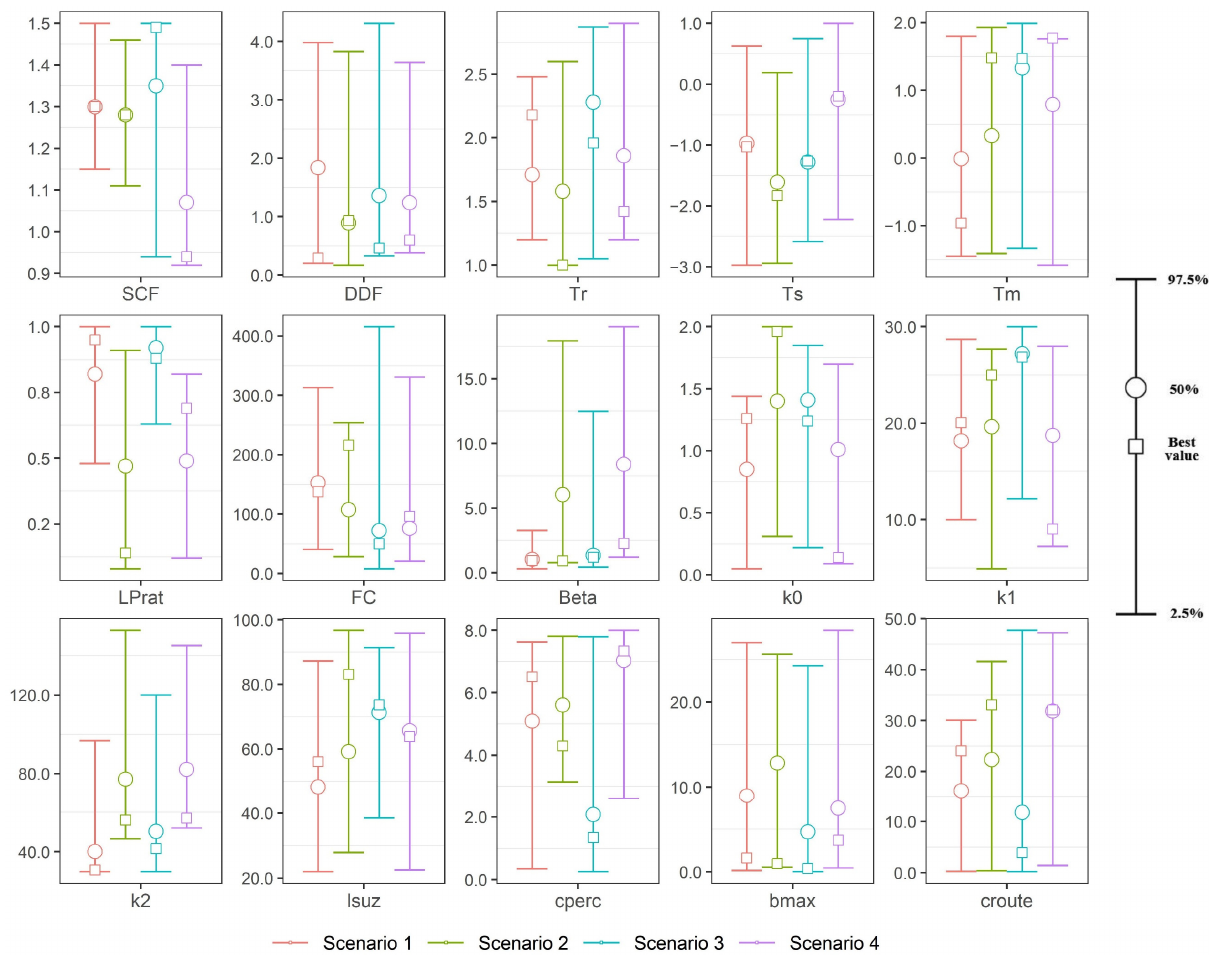
Figure 5. The 95 percent prediction uncertainty (95PPU) for model parameters during the calibration period (2015–2016) obtained by 2572 user-defined behavioral parameter sets (KGE > 0.3).